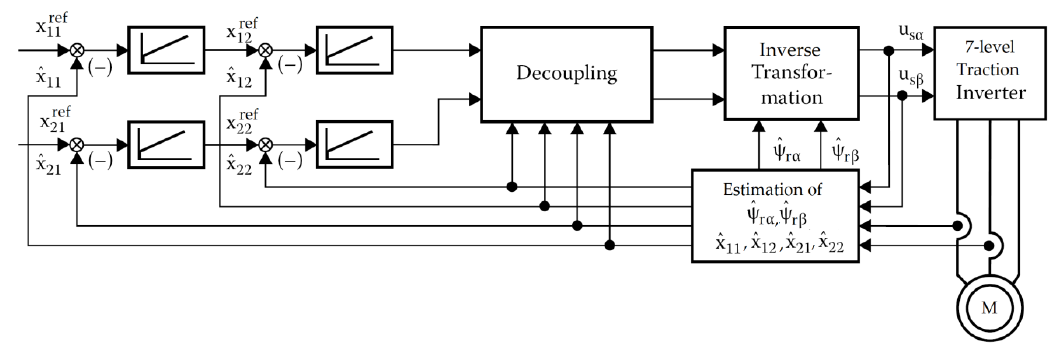
Figure 17. The basic structure of the multiscalar model based control system for the traction motor.